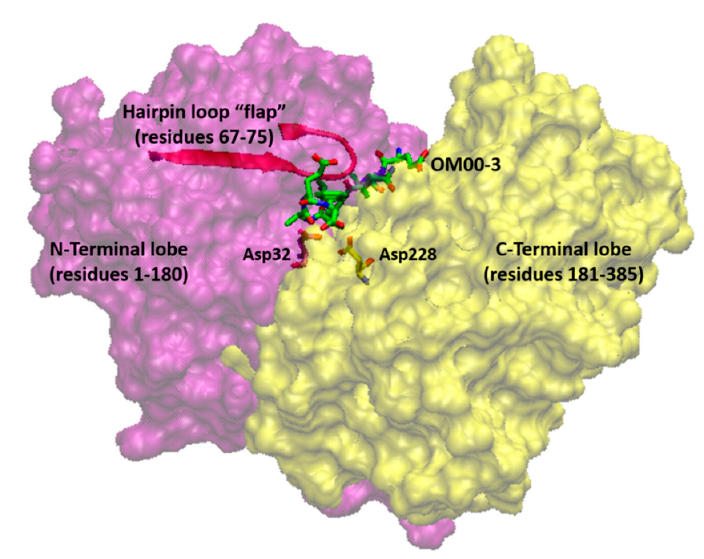
Figure 2. Three-dimensional structure of human BACE1 (PDB ID: 1FKN). The N-terminal lobe is colored in magenta and the C-terminal lobe is colored in yellow. The active site with the catalytic dyad of Asp32 / Asp228 is located at the center of the two lobes with the co-crystallized inhibitor OM00-3.